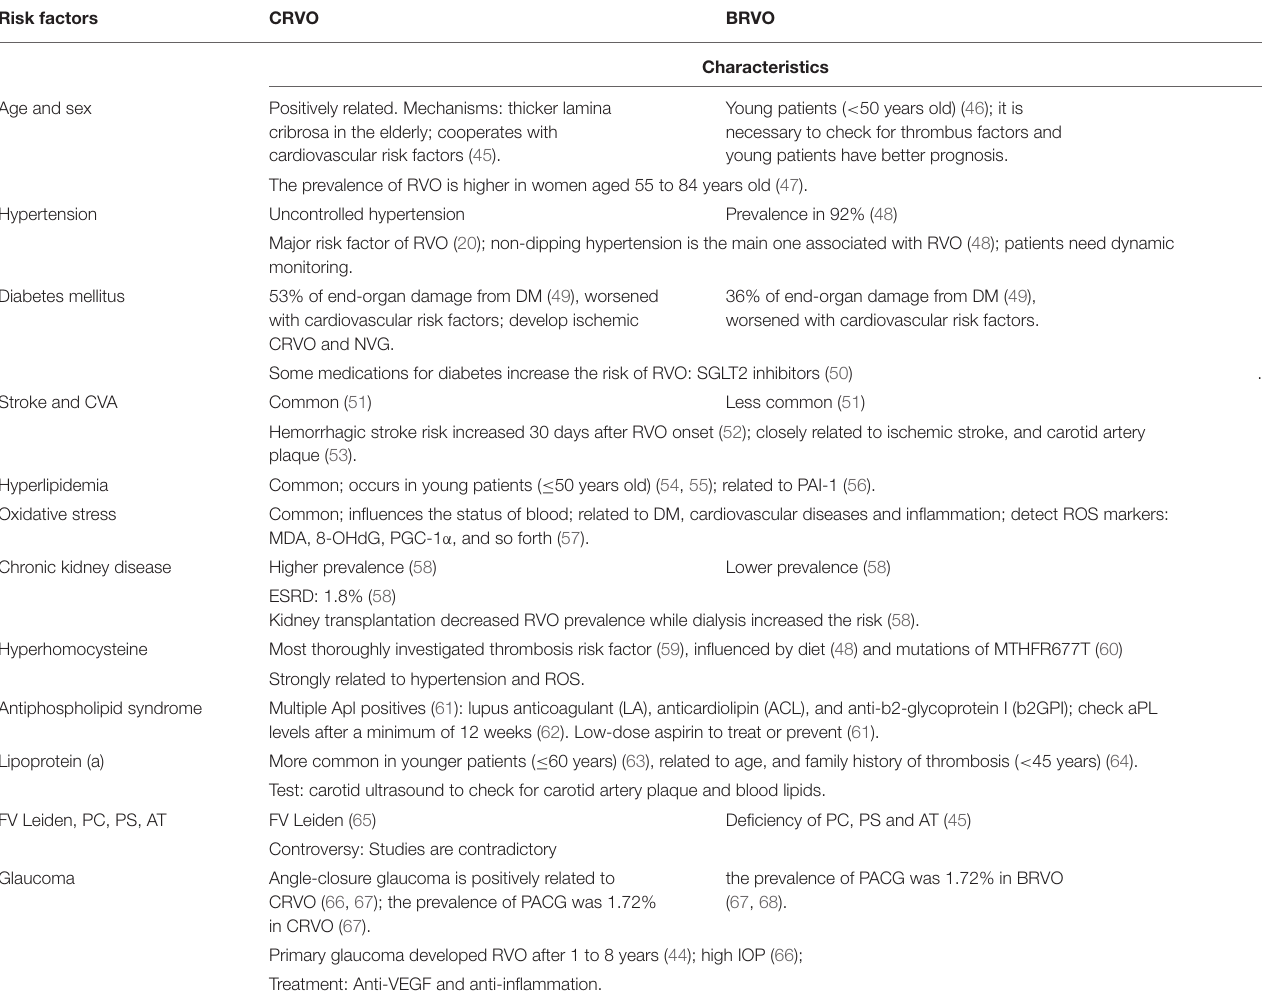
TABLE 1 | Characteristics of CRVO and